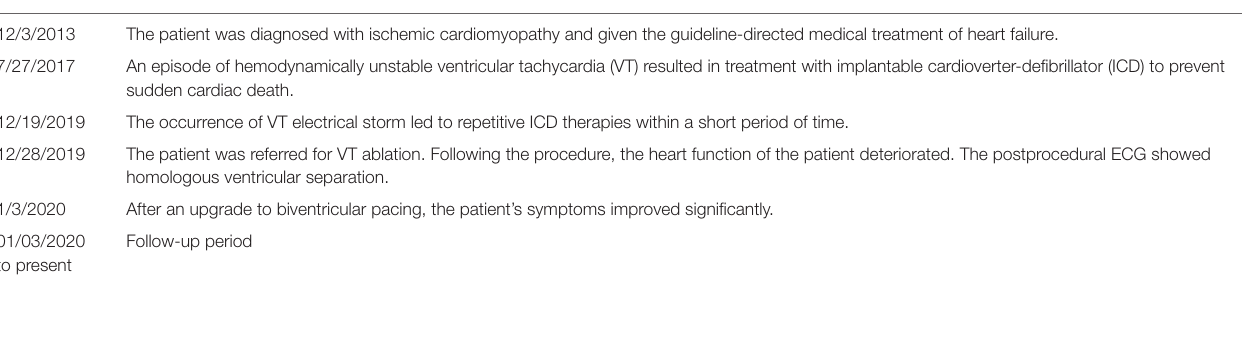
TABLE 1 | Detailed timeline of clinical course of the